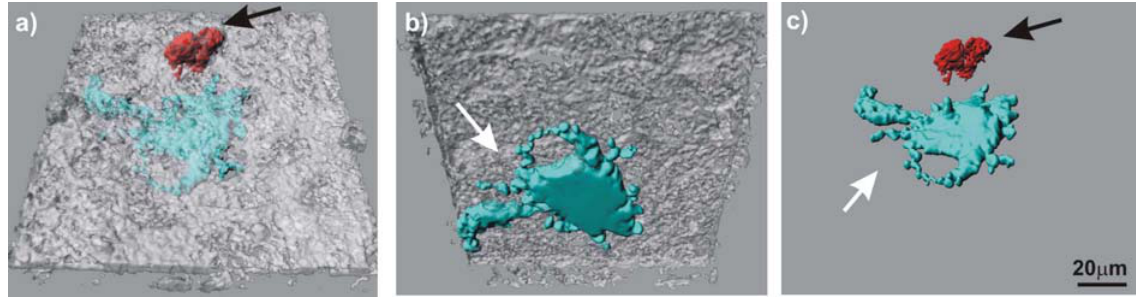
Figure 3 LSM images of the triple cell co-culture model . Epithelial cells (16HBE14o-), MDM and MDDC were co- cultured fixed and stained for F-actin (Phalloidin-rhodamine, white). Additionally, the MDM and MDDC were stained for specific surface markers CD14 (red), and CD86 (light blue), respectively. The cultures were observed with a Zeiss 510 Meta laser scanning microscope at a Z-interval of 0.3 μ m, resulting in total 70 layers. Digital image restoration was performed using the IMARIS software from Bitplane AG. Epithelial cells (white, transparent volume rendering), MDM (red, surface rendering; black arrows), and MDDC (light blue, surface rendering; white arrows) are shown. The same data set is shown from top (A), from bottom (B), and without epithelial cells from top (C).